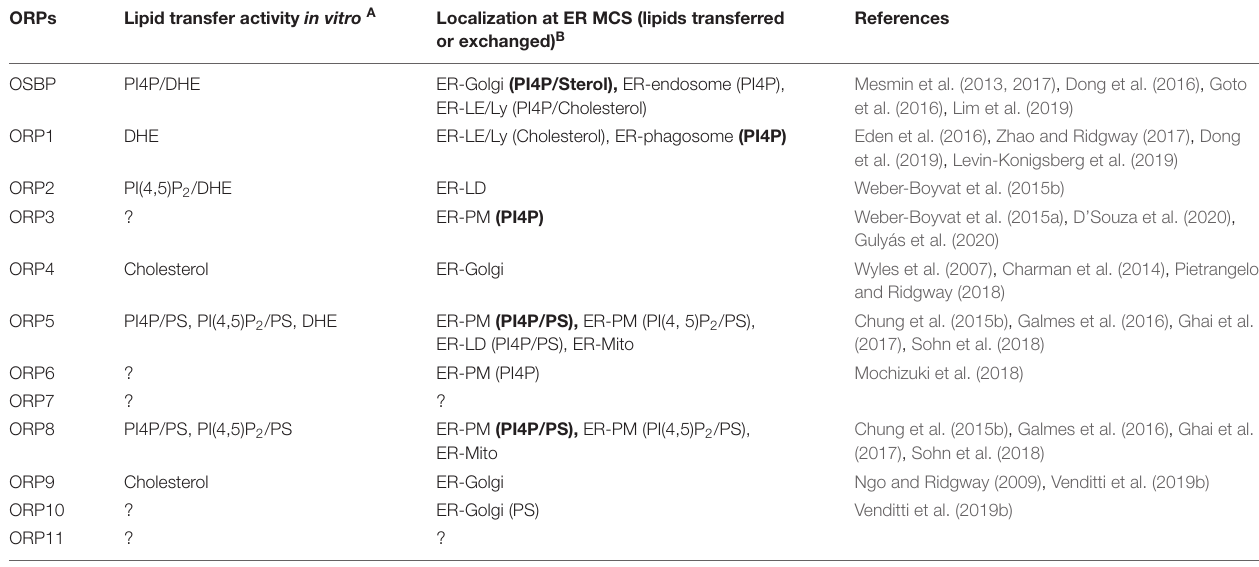
A Lipids were transported or exchanged between liposomes in vitro. The exchanged lipids are separated by slash (/). B Lipids demonstrated to be transported or exchanged in intact cells are shown in parentheses. The exchanged lipids are separated by slash (/). B Lipids shown in bold font: transport or exchange of the indicated lipids has been demonstrated in loss-of-function or gain-of-function analysis in an acute manner (e.g., acute inhibition or manipulation of ORP proteins). B Lipids shown in regular font: transport or exchange of the indicated lipids has been suggested in loss-of-function or gain-of-function analysis in a chronic manner [e.g., chronic inhibition (knock-down or knock-out) or overexpression of ORP proteins]. ?,